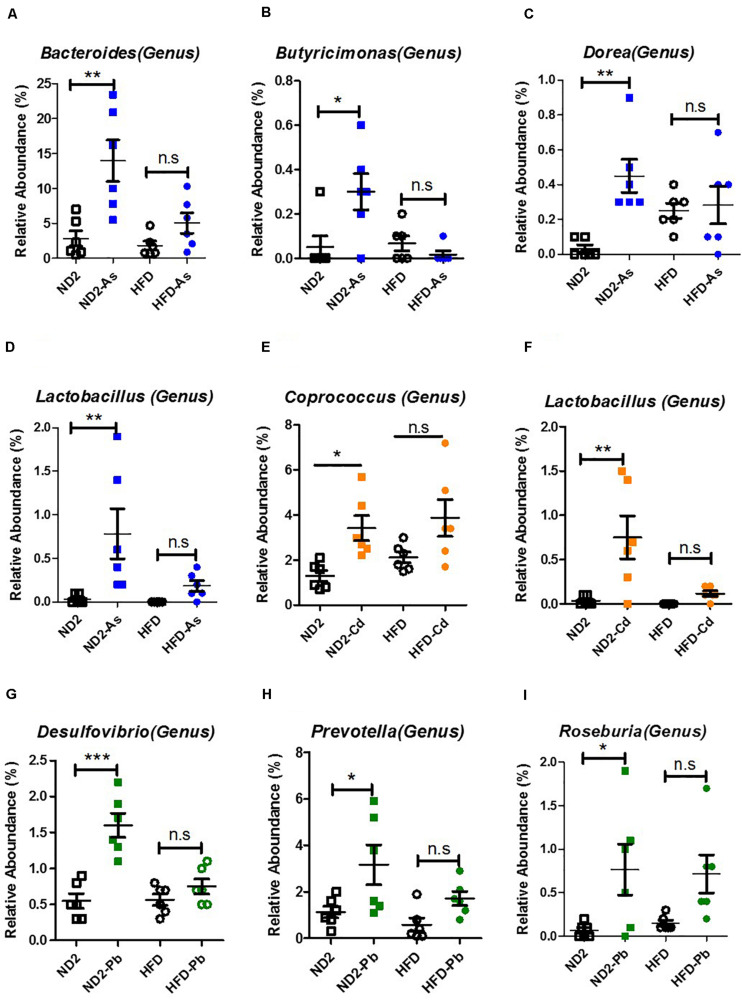
Microbial genus enriched significantly by heavy metals primarily in ND-fed mice. ND- and HFD-fed mice were exposed to 100 ppm As, Cd, or Pd for 10 weeks (n = 6 for each group). Cecum feces was collected for gut microbiota analysis by 16S rRNA gene sequencing. (A)
Bacteroides in the Bacteroidetes phylum, Bacteroidia class, Bacteroidales order, Bacteroidaceae family. (B)
Butyricimonas in the Bacteroidetes phylum, Bacteroidia class, Bacteroidales order, Odoribacteracea family. (C)
Dorea, (E)
Coprococcus, and (I)
Roseburia in Firmicutes phylum, Clostridia class, Clostridiales order, Lachnospiraceae family. (D,F)
Lactobacillus salivarius in the Firmicutes phylum, Bacilli class, Lactobacillales order, Lactobacillaceae family. (G)
Desulfovibrio in Proteobacteria phylum, Deltaproteobacteria class, Desulfovibrionales order, Desulfovibrionaceae family. (H)
Prevotella in Bacteroidetes phylum, Bacteroidia class, Bacteroidales order, Prevotellaceae family. Data are expressed as mean ± SEM. Statistics according to two-way ANOVAs and Bonferroni post hoc tests. n.s. not significant; *P < 0.05; **P < 0.01; ***P < 0.001.